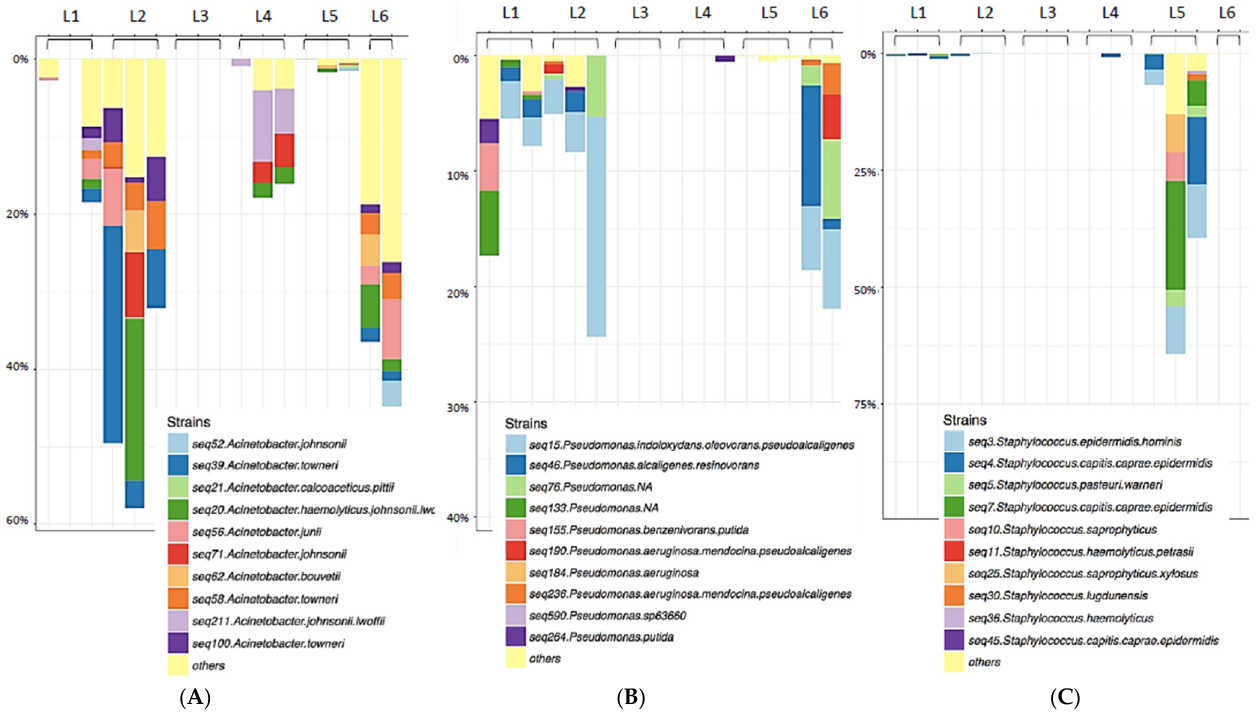
Figure 3. Genus-specific Taxa plots displaying Acinetobacter ( A ), Pseudomonas ( B ), or Staphylococcus ( C ) species diversity. Species diversity of key biofilm-forming nosocomial pathogens identified on sentinel washcloths (one per washing machine) after laundering in public washing machines.